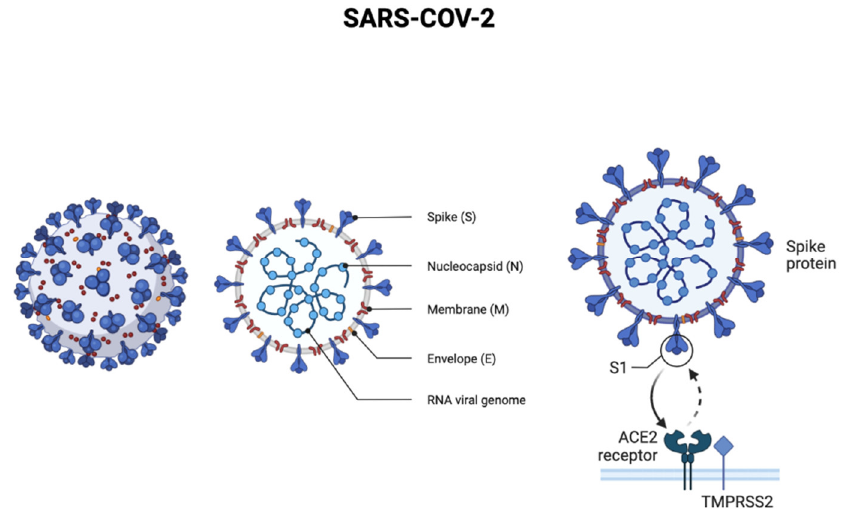
Figure 1. Sars-COV-2 virus representation.